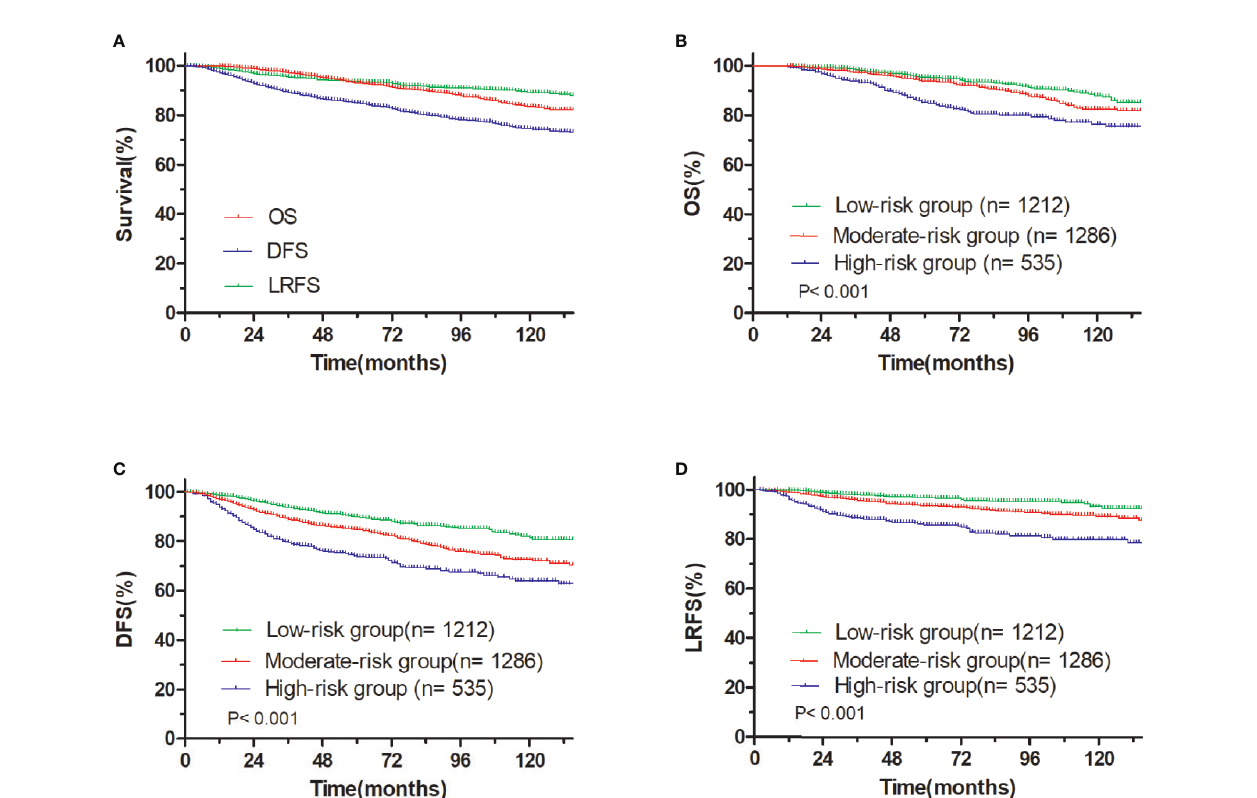
FIGURE 3 | OS and DFS and LRFS for all patients. (A) pT1-2N1M0 breast cancer, (B) OS, and (C) DFS, and (D) LRFS for patients with pT1-2N1M0 breast cancer strati fi ed into the low- and moderate- and high-risk